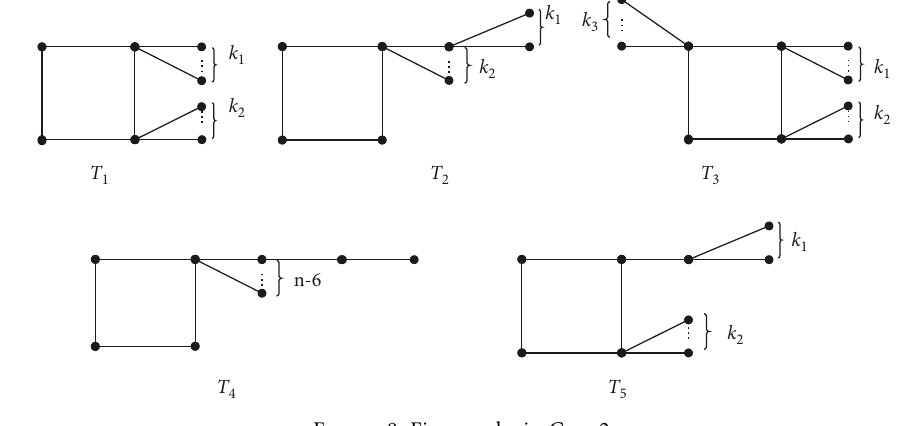
Figure 8: Five graphs in Case